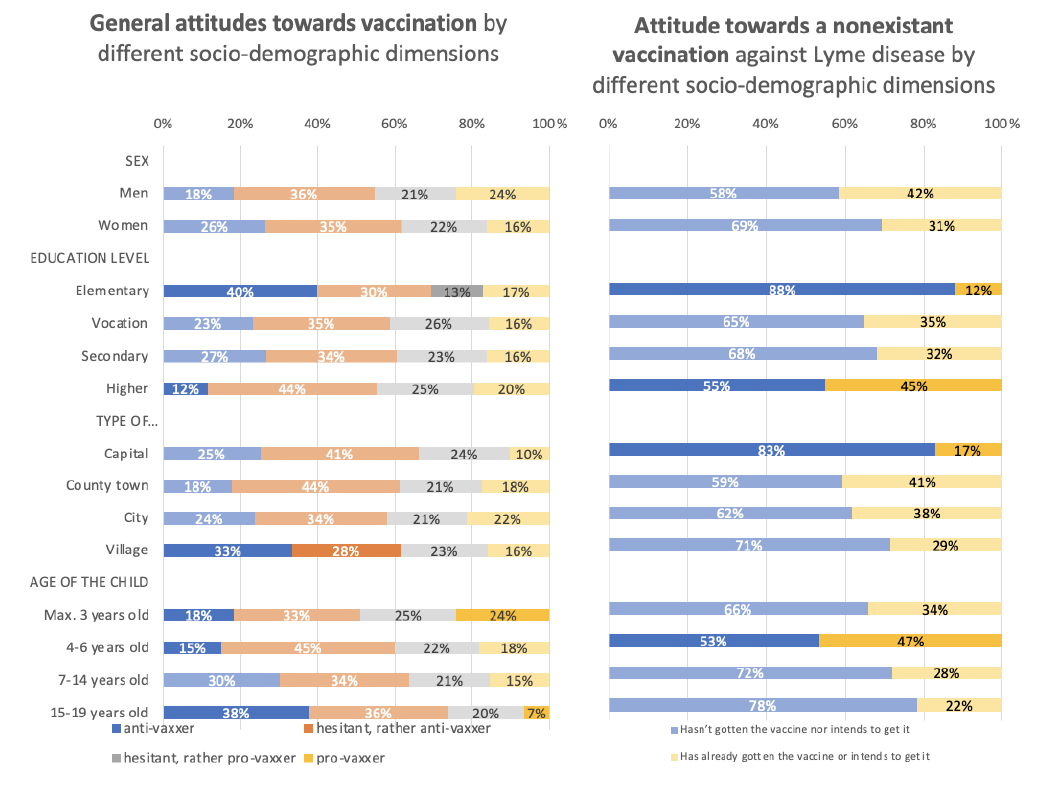
Figure 2. The sociodemographic description of vaccine hesitancy based on general attitude toward vaccination and the Piresian indicator.